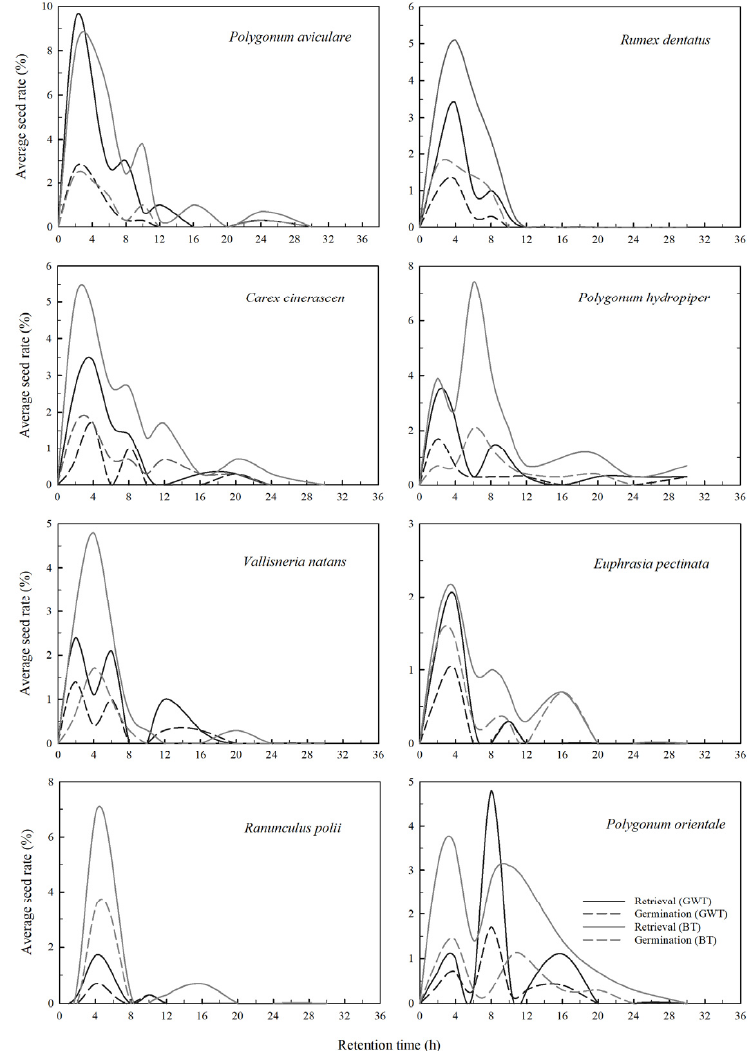
Figure 1. Average seed rate of recovered (smoothed solid line) and germinated (smoothed dashed line) seeds in each time interval, including eight plant species. Germination was calculated by germinated seeds per time interval and the total ingested per feeding trail. Retrieval represented the rate of seeds recovered in each time interval to the total ingested seeds during each period. GWT: green-winged teal, BT: Baikal teal.